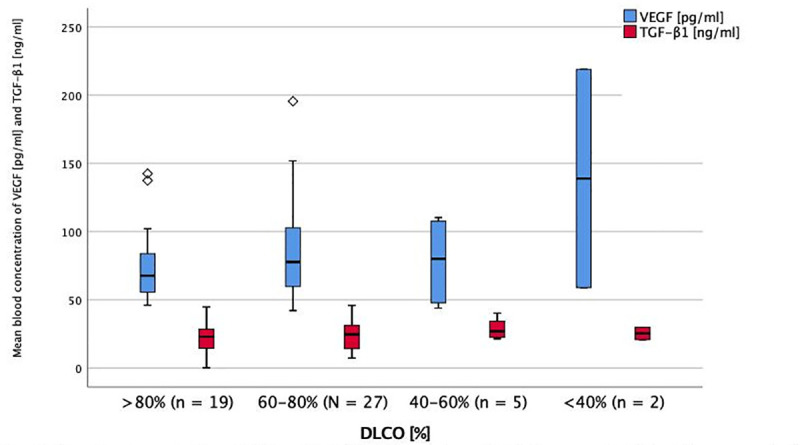
Serum levels of and TGF-ß1 and VEGF in impairment OF DLCO at baseline.Mean blood concentration of VEGF and TGF-B1 in different stages of DLCO impairment. DLCO = diffusion capacity for carbon monoxide. TGF-B1 = transforming growth factor beta-1. VEGF = vascular endothelial growth factor. * = p < 0.05 (ANOVA + Tukey-test as post-hoc test for multiple comparisons). No significant difference between groups.